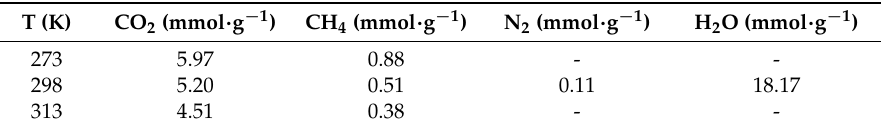
Table 1. Affinity of BILP-19 for CO 2 , CH 4 , N 2 and H 2 O at 273 K, 298 K and 313 K taken from the respective isotherms at 0.95